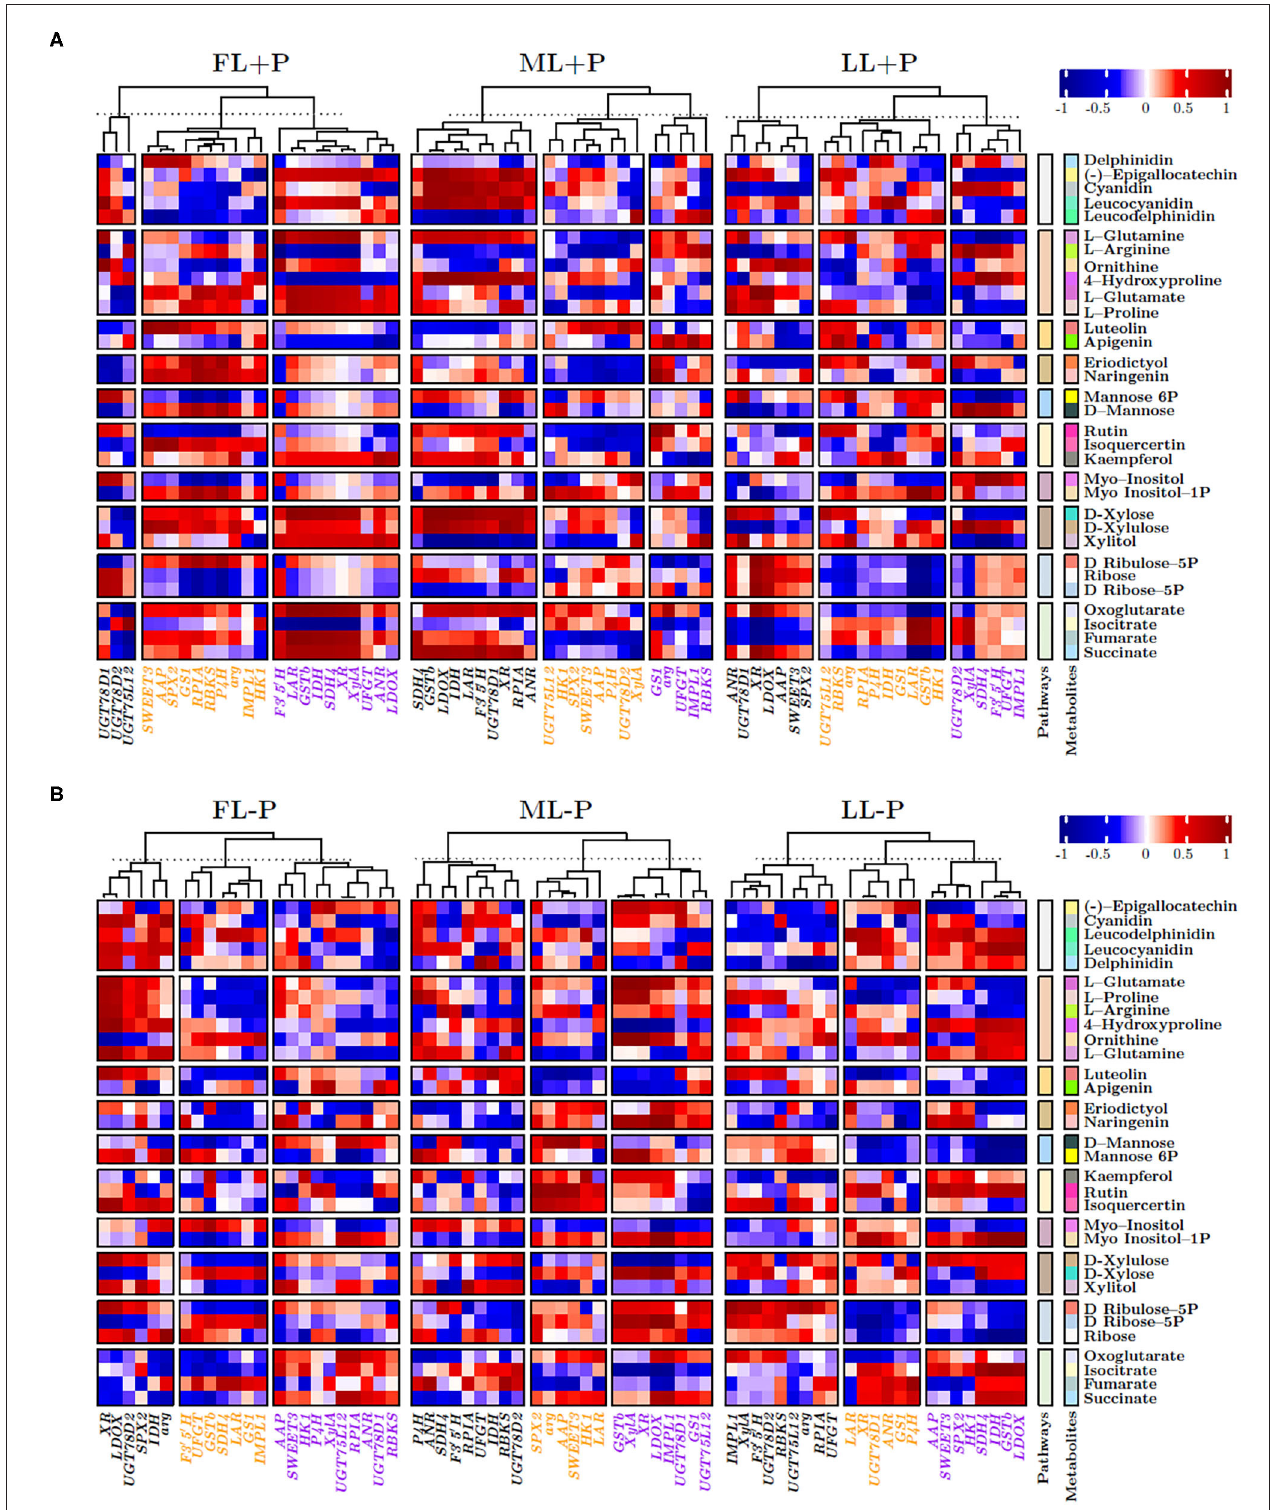
FIGURE 8 | (A,B) Heatmap correlation between P and genes under different P levels and light intensities.